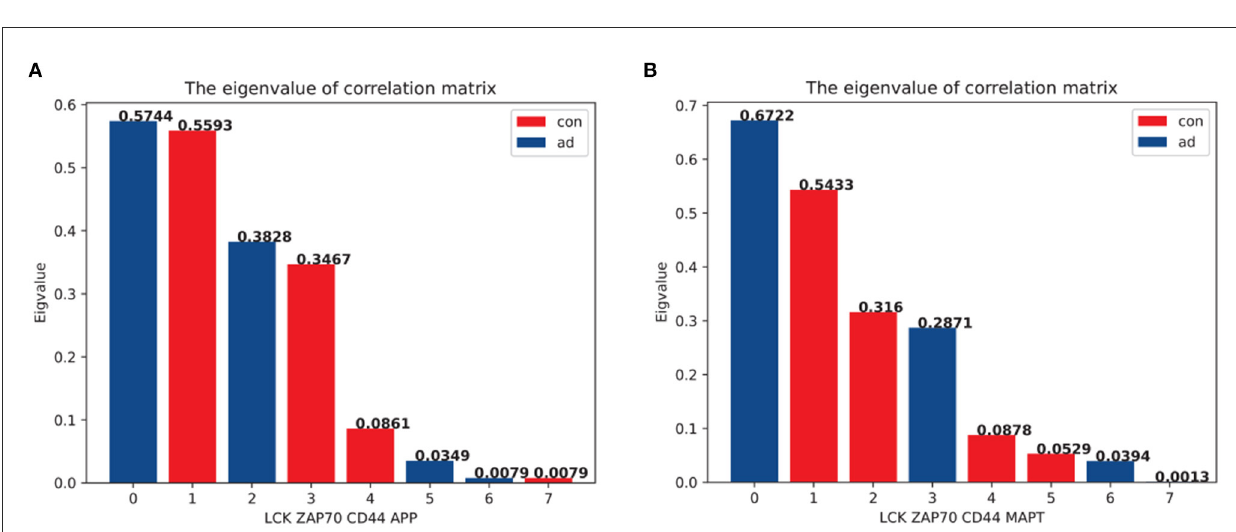
FIGURE6 The eigenvalue of the inner product matrix of the top three hub genes. The eigenvalue has been standardized for the purpose of comparison in a different matrix. The blue bar represents the eigenvalue in the AD expression matrix, whereas the red bar represents the eigenvalue in the control group expression matrix. (A) The eigenvalues based on the matrix were representative of LCK , ZAP70 , CD44 and APP . (B) The eigenvalues based on the matrix were representative of LCK , ZAP70 , CD44 , and MAPT .